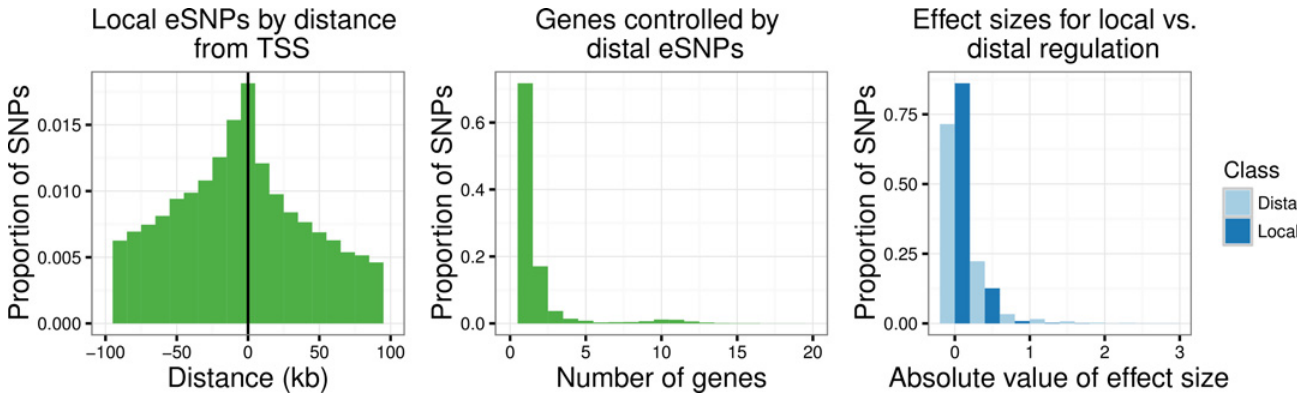
Fig 2. Characteristics of local and distal eSNPs. Position of local eSNPs relative to transcription start site (TSS) of the gene queried by the associated probe (left). Number of genes controlled by distal eSNPs (center), excluding SNP kgp22834062, which was associated to 129 genes. Effect sizes (absolute values of the regression coefficients) of the most significant SNP for each probe with any local or distal associations